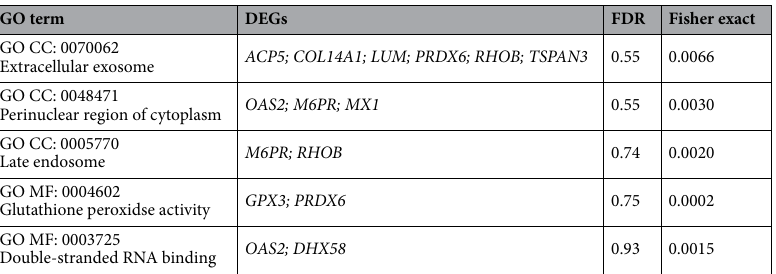
Table 4. Gene ontologies (GO) terms evaluated for DEGs common in the myometrium, endometrium, and conceptuses of pigs during the peri-implantation period that were fed a restrictive diet during the peri- conceptional period comparing to the myometrium of pigs during the peri-implantation period that were fed a normal diet during the peri-conceptional period. CC cellular components, MF molecular function.